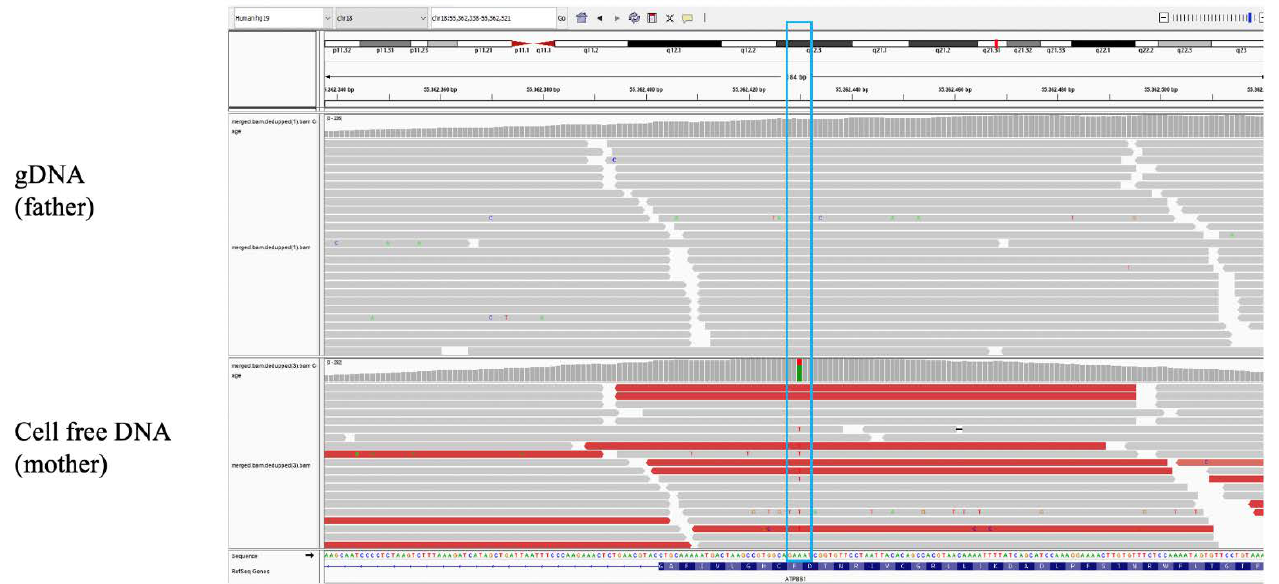
Figure 2. Integrative Genomics View (IGV) representation of the ATP8B1 variant in cffDNA and in paternal gDNA. The ATP8B1 missense variant c.[913T > A] + [=]p.[Phe305Ile ] + [=], reported in the heterozygous state in dbSNP (rs150860808), gnomAD v2.1.1 (0.1%), and 1000G (0.09%), was detected in cffDNA with a ratio of 31% as compared to the wild-type allele. The imbalanced allelic ratio, wild-type (WT) allele/mutated allele, with an overrepresentation of the WT allele, would be associated with healthy fetuses. The WT allele is indicated in green, while the mutated allele is shown in red. Considering that the fetal fraction was 10%, these data suggested that the fetuses did not receive the missense maternal variant having a frequency of 31%, but rather those having a frequency of 50 or more readings. Postnatal WES confirmed that the two newborns were wild type for the ATP8B1 variant. The cffDNA sequencing was carried out at a greater reading depth than the genomic one; cffDNA coverage average 277 × , gDNA coverage average 103 × . The blue box indicates the nucleotide change in the